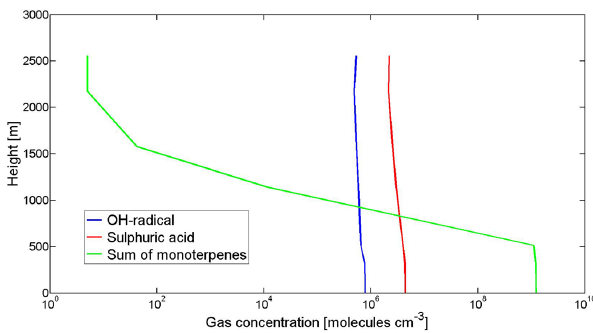
Fig. 6. Vertical profiles of OH-radical, sulphuric acid and sum of monoterpenes concentrations for 26 March 2003 at 11:2a.m.